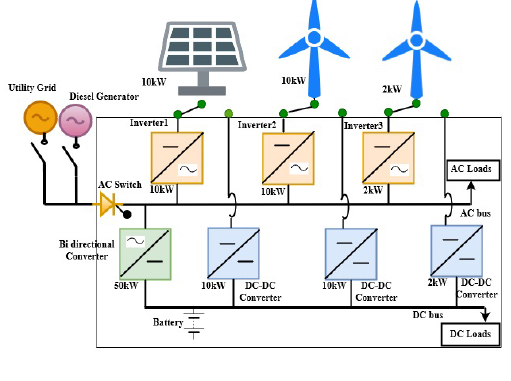
Figure 1. Aichi micro grid test system (Building 12)